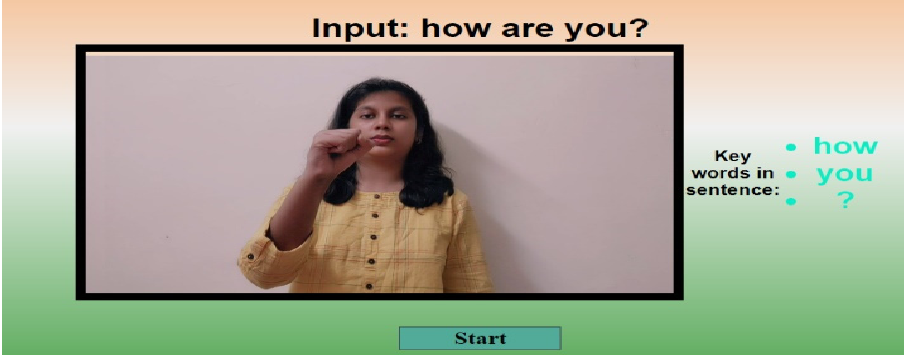
Figure 19. Case 9. Available video for